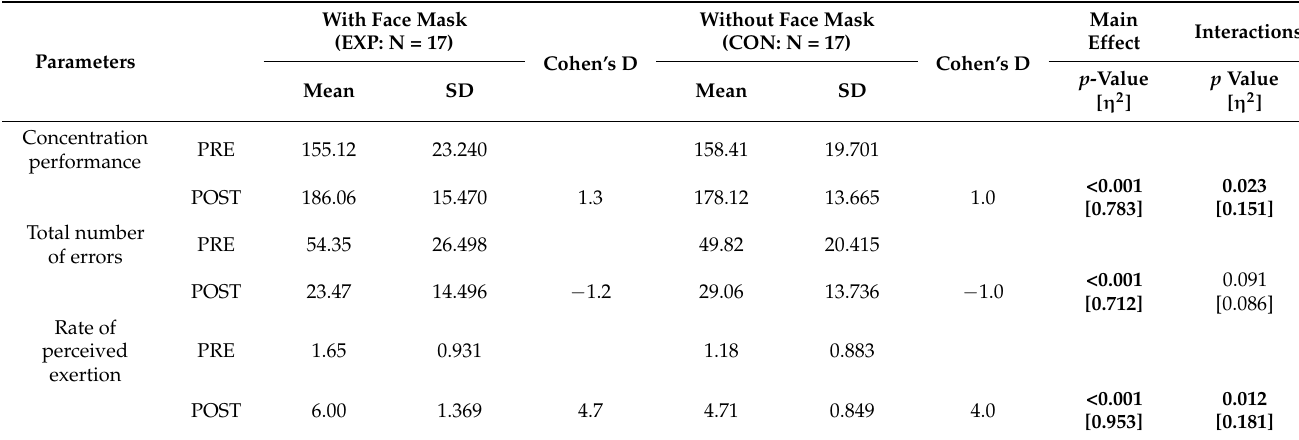
Table 1. Comparison of cognitive function assessment between those who wore the facemask and those who did not, following a warm-up